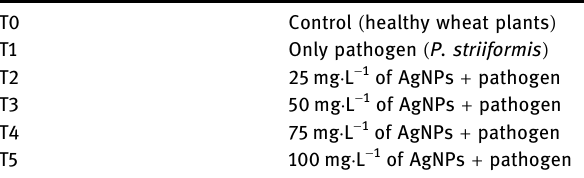
Table 3: Rating scale for yellow rust disease